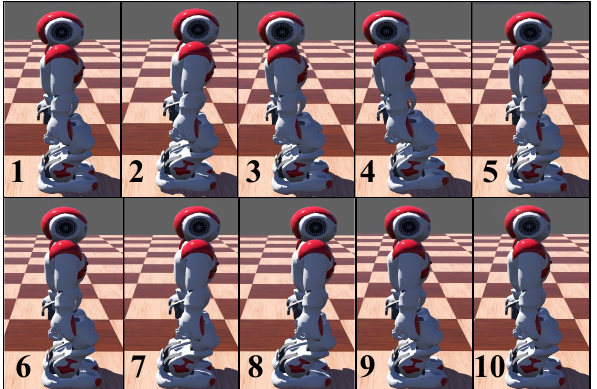
Figure 5. Snapshot sequences of double-leg support. The swing motion caused by the external force, F ext = 15 N, is significantly suppressed under the action of the CPG controller. ( 1 – 5 ): with- out CPG, the robot swings forth and back under the external force. ( 6 – 10 ): with CPG, the robot moves its body forward to counteract the swing motion caused by the same external force and no backward movement.